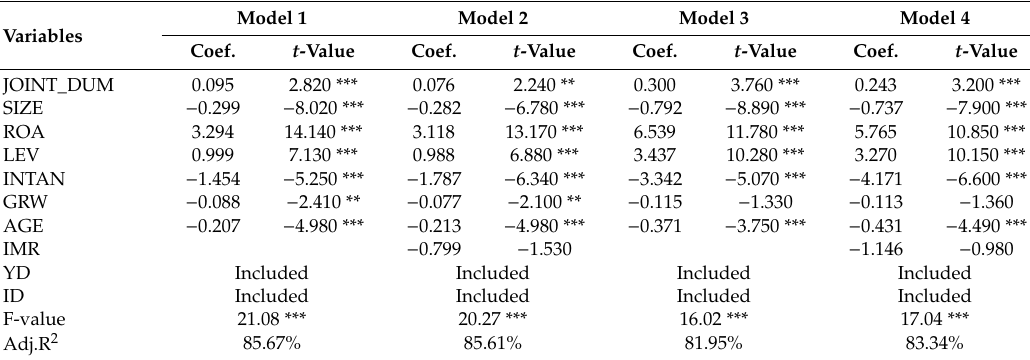
Table 9. Analysts’ cash flow forecasts issuance and firm value.